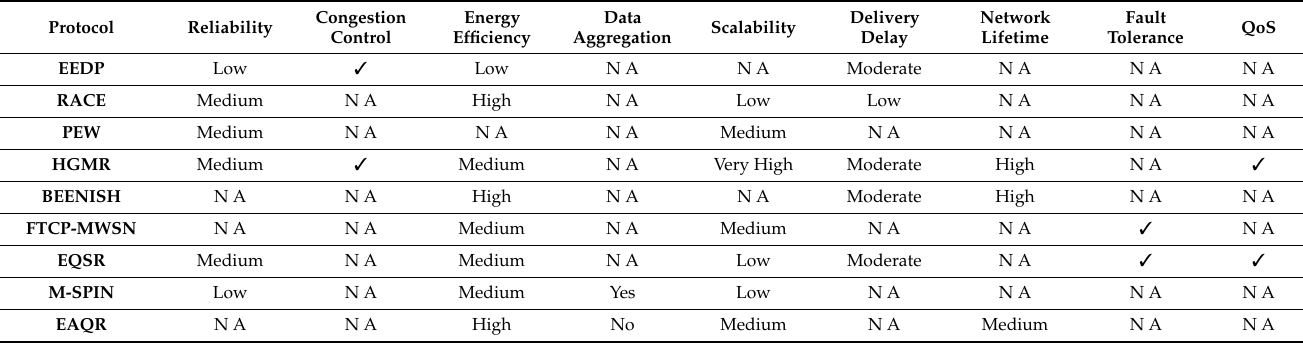
Table 11 establishes a comparison between some routing protocols from different categories [121]. Table 11. Between different types of routing protocols for WSNs.